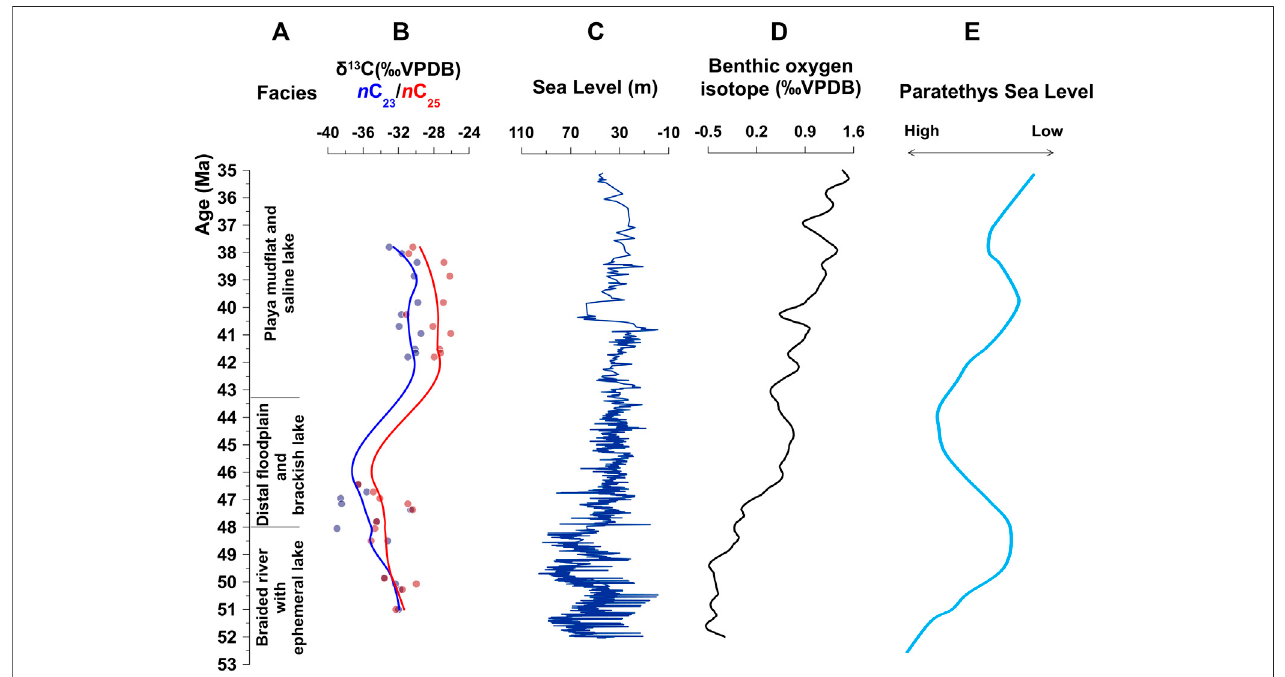
FIGURE 6 | (A) Sedimentary facies in the Nangqian Basin (this study); (B) red and blue dots and the corresponding fi tted curve indicating the δ 13 C of mid-chain alkanes n